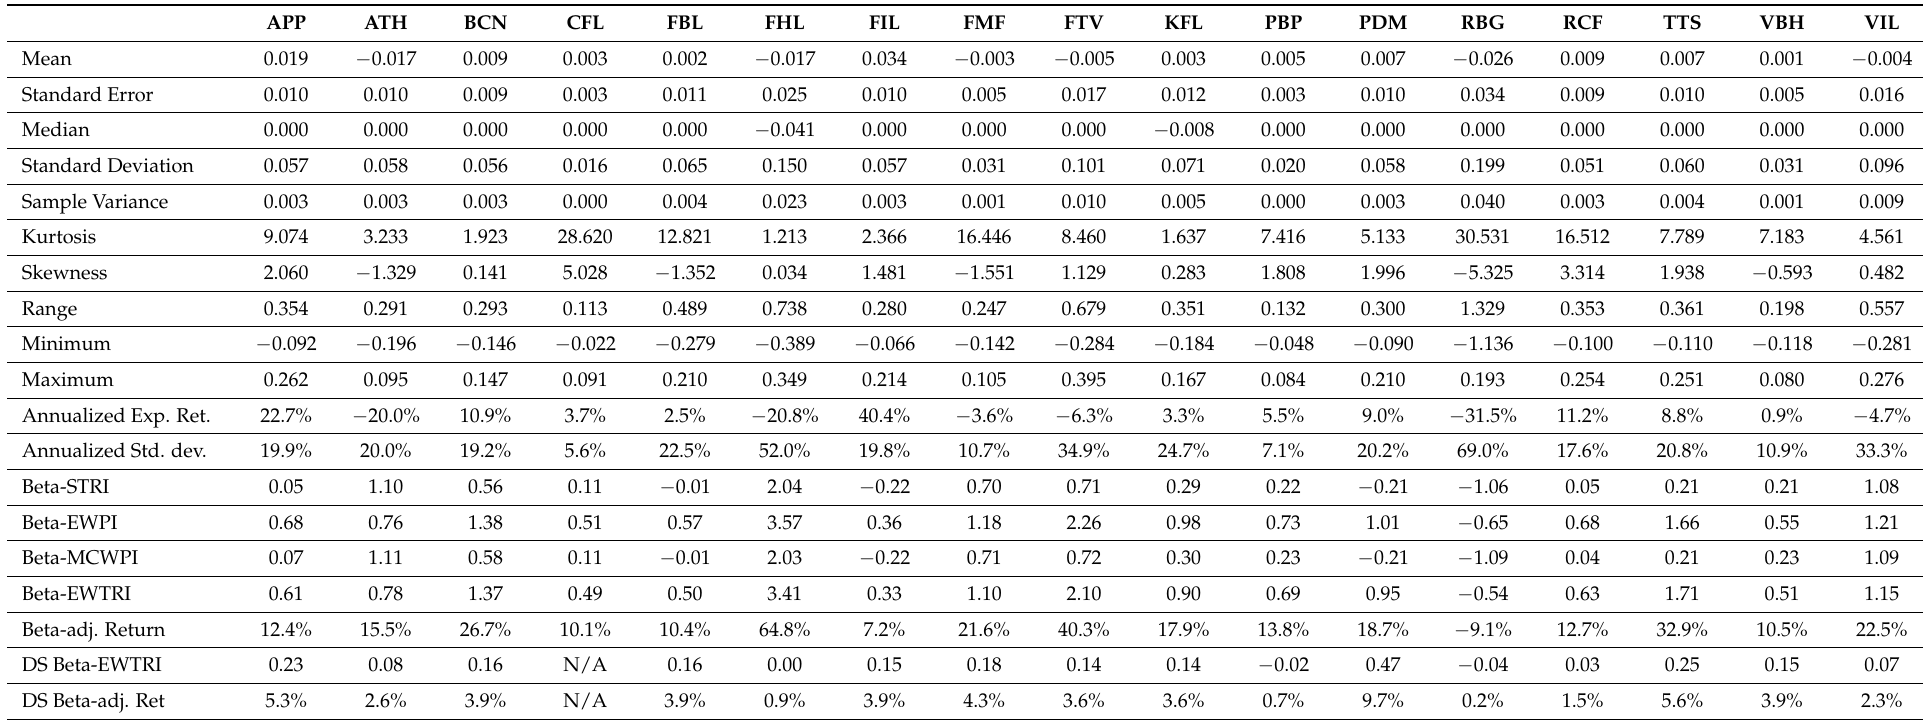
Table 1. Descriptive statistics (monthly data: September 2019–July